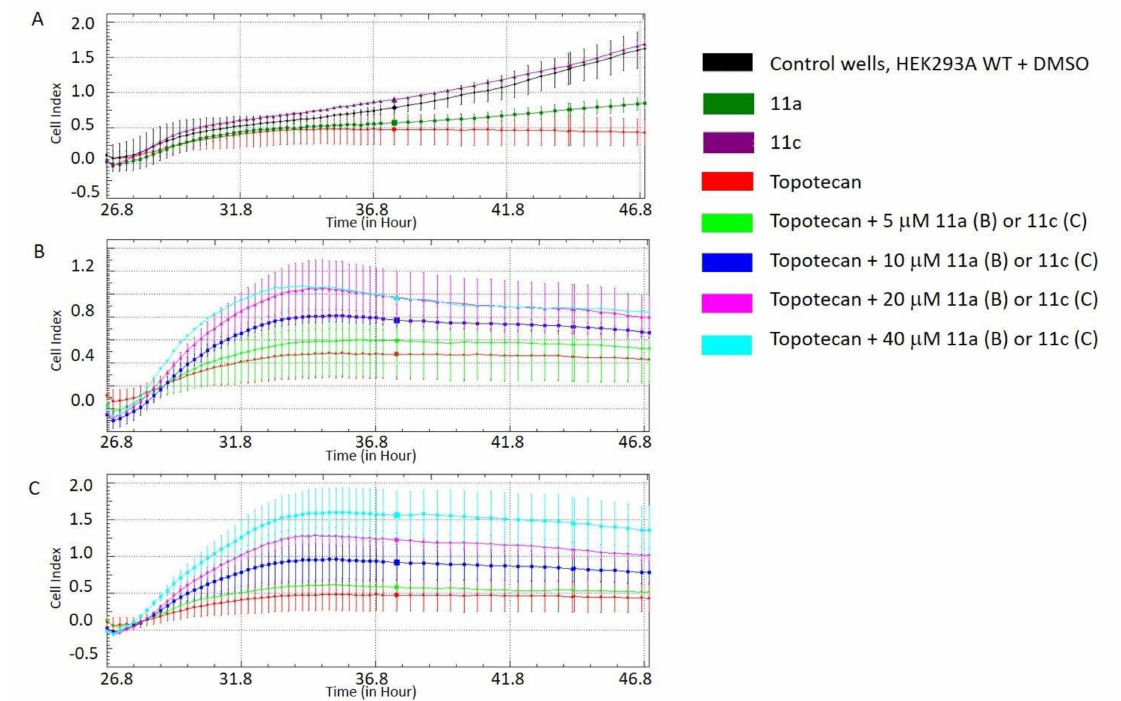
Figure 9. Compounds 11a and 11c stimulated cell growth of HEK293A WT cells with Tpc, as compared to Tpc, using the impedance-based real-time assay. ( A ). Cell growth of HEK293A cells in the control wells without compounds added (black), with 50 nM Tpc (red), 40 µ M 11a (dark green), or 40 µ M 11c (violet). ( B , C ) Cell growth of HEK293A cells with 50 nM Tpc only (red) and in combination with 5 µ M (green), 10 µ M (dark blue), 20 µ M (pink), or 40 µ M (blue) 11a ( B ) or 11c ( C ). In cancer HeLa cells, all four TDP1 inhibitors showed promising synergy in conjunc- tion with Tpc (Figure 10). The combination index (CI) values were determined for